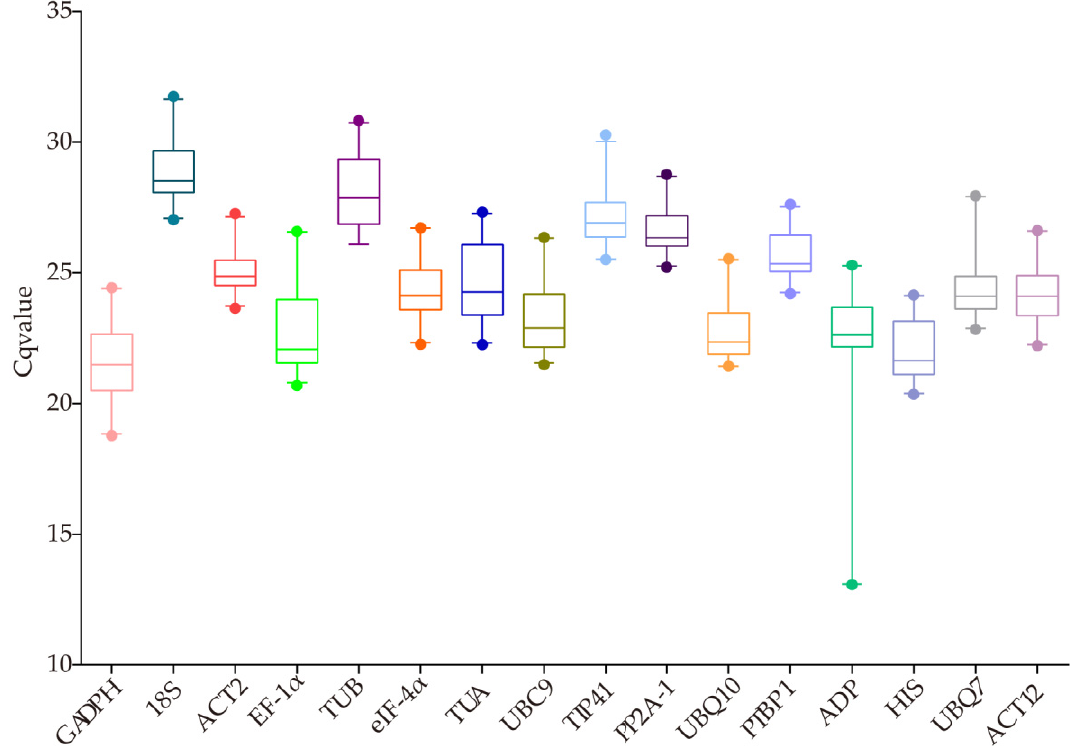
Figure 1. Distribution of raw Cq values for the 16 candidate reference genes (RGs) across all Larix olgensis samples. The lines inside each box represent the medians. The outside box is determined from 25th to 97.5th percentiles. The top and bottom whiskers represent the highest and lowest Cq values, respectively.